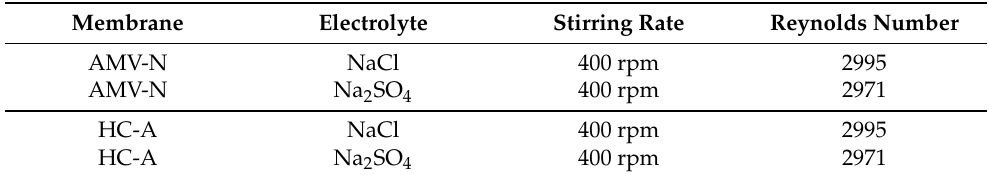
Table 2. Experimental conditions applied in the evaluation of the effect of the type of counter-ion on the development of